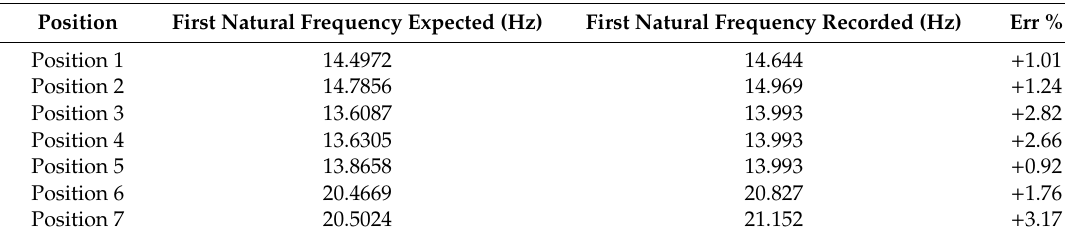
Table 3. Comparison of the first natural frequency in the seven reference positions obtained by applying a force with saturated ramp profile at the end e ff ector along z-axes (no